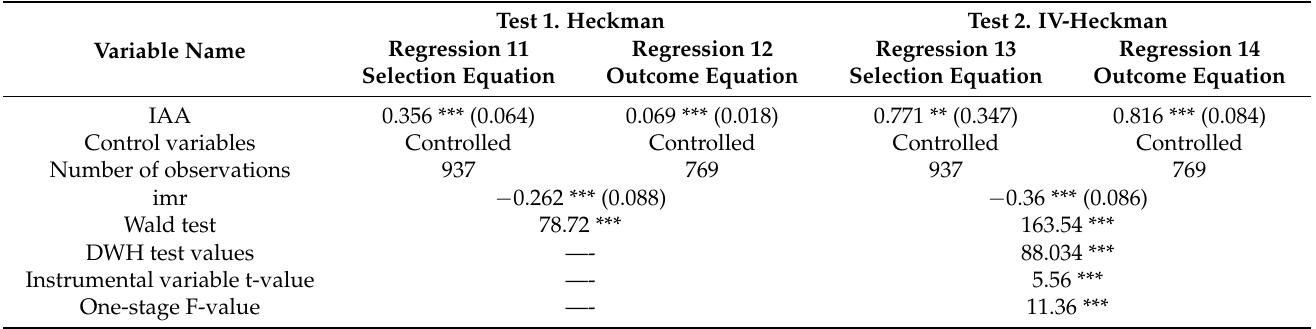
Table 11. Robustness results for switching measurement